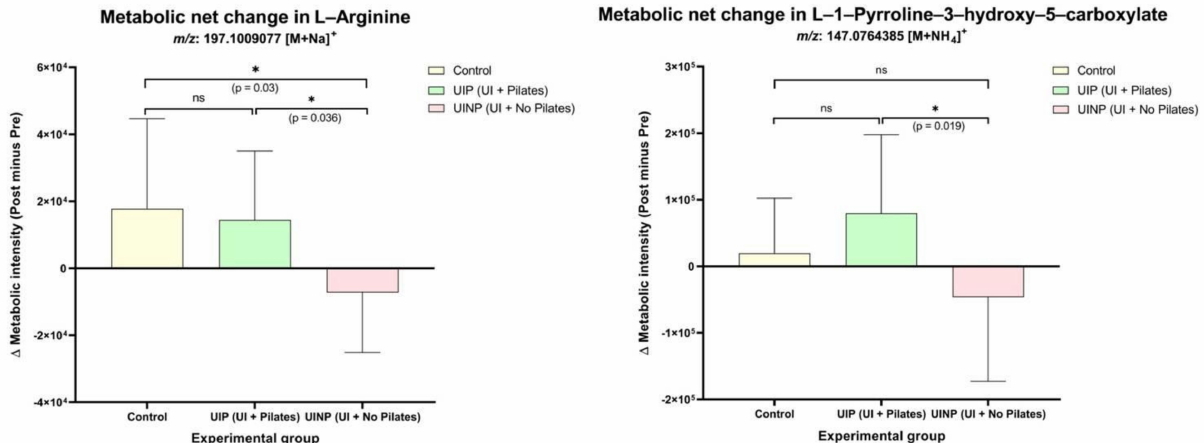
Figure 5. Net change in identified metabolic features associated with FMP ratio between pre- and post-intervention in Control, UIP, and UINP. Control: control group; UIP: urinary incontinence group with Pilates; UINP: urinary incontinence group with no Pilates; m / z : mass-to-charge ratio in ions that quantifies molecules in chemical or biological mixture; ∆ metabolic intensity (post minus pre): metabolic net difference where MPI in pre-intervention substracted from post-intervention. * ( p < 0.05): significantly different between groups. ns means non-significant.